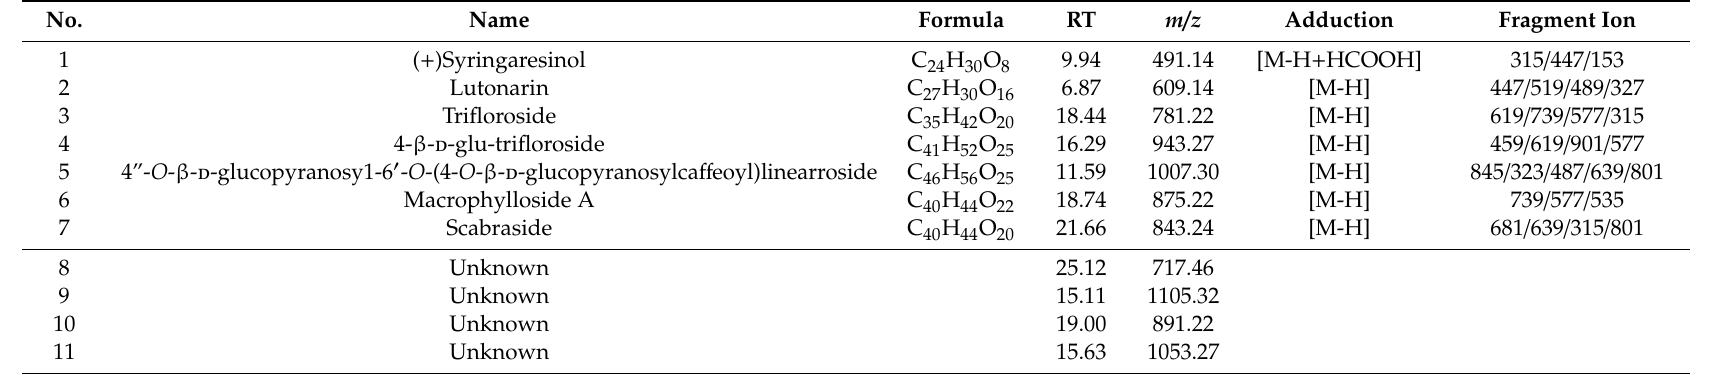
Table 2. Identification of chemical markers from two species of